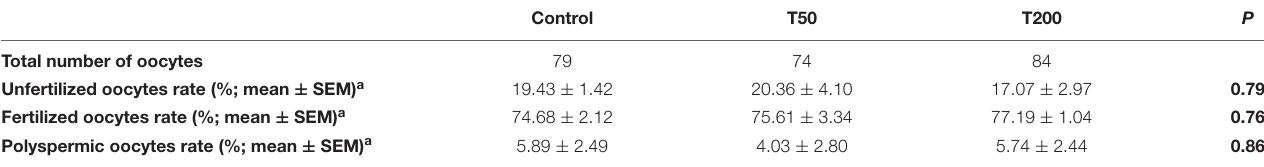
TABLE 1 | Pronuclei formation in Control, T50, and T200